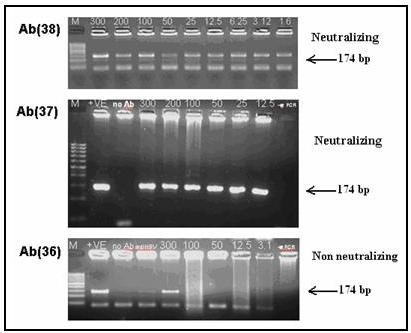
Viral neutralization by anti E2 peptide goat antibodies. Purified mono-specific polyclonal antibodies against p36–p38 epitopes were used at 300 to < 12.5 μg/tube to bind HCV from infected sera and the immune-capture activity of each Ab was assessed by RT-nested PCR amplification. The 174 bp amplicon denotes the presence of captured virus. The immune-capture experiment was repeated 3 times with different serum samples. Each Ab displayed the same immune-capture activity with different infected sera. Negative control and binding specificity were assessed by replacing the anti peptide Ab by PBS and anti HBV Ab respectively.